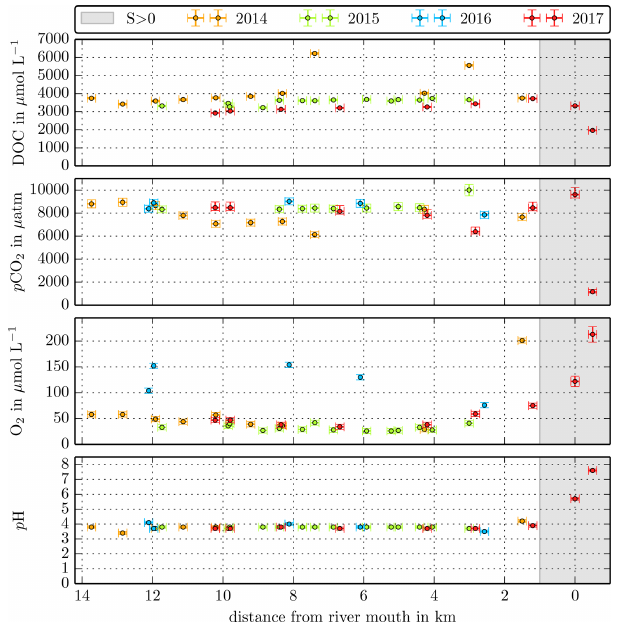
Figure B1. Individual DOC, CO 2 , O 2 , and pH measurements in the Maludam River versus the distance from the river mouth. Differ- ent colours stand for the individual river campaigns, and the grey shaded area indicates regions of S > 1 that were excluded from the data in this